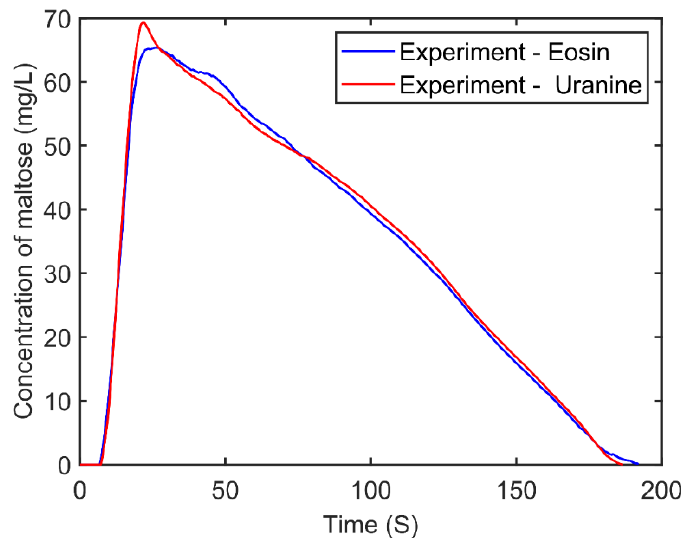
Figure 3. Validation of fluorescent experiments using eosin Y. Figure A3. Validation of fluorescent experiments using eosin Y.